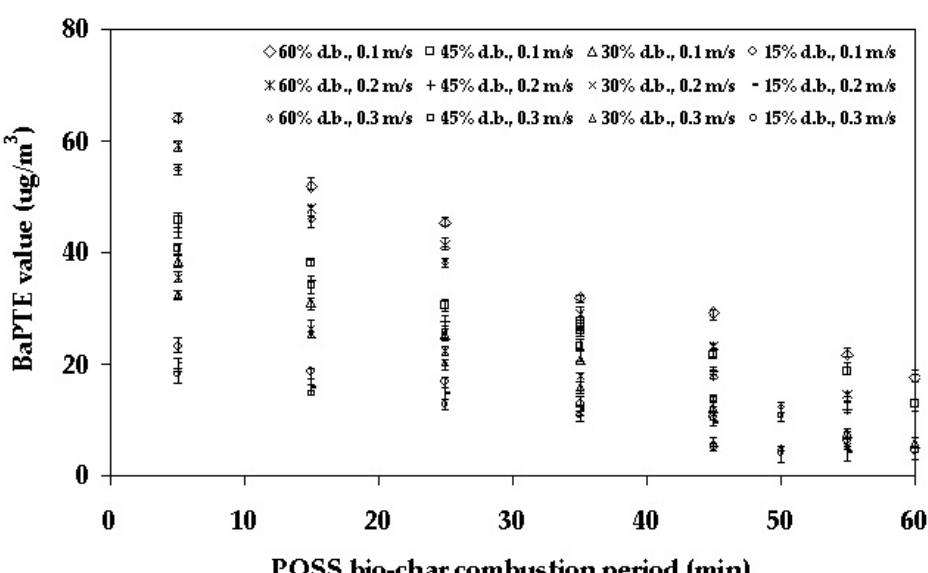
Figure 10. BaPTE value in the smoke particle samples from the POSS bio-char combustion for different the clean air speeds and moisture contents.